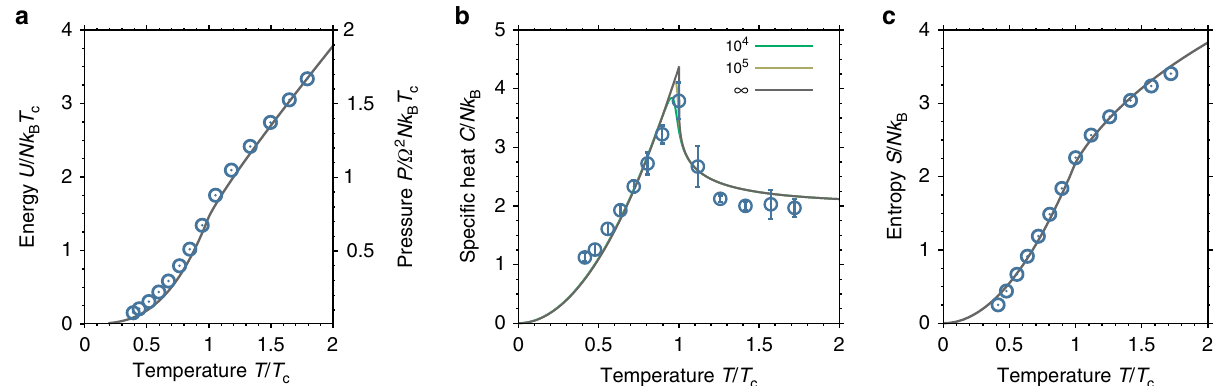
Figure 3 | Caloric and entropic properties. ( a ) Internal energy (per photon) U normalized to the characteristic energy k B T c as a function of the reduced temperature T / T c . In the classical high-temperature regime, energy scales linearly with temperature as is expected from Maxwell–Boltzmann-like statistics. The formation of the condensate is signalled by a change in slope close to T ¼ T c . For an ideal two-dimensional trapped Bose gas, which is realized in our experiment in good approximation, the internal energy of the photon gas can moreover be linked to its pressure P by P ¼ (1/2) O 2 U , see axis on the right- hand side and the main text for details ( O is the trapping frequency). Experiments are carried out at constant temperature T ¼ 300K and photon numbers ranging from N E 30,000 to N E 550,000, whereby an increase of the photon number corresponds to a decrease in the critical temperature T c ¼ T c ( N ) of the system. s.e.m.’s are smaller than the point size. ( b ) Specific heat (per photon) versus the reduced temperature T / T c , showing a cusp singularity at criticality (circles). In the high-temperature (classical) regime, the specific heat reaches a limiting value of 2 k B per photon. At criticality T ¼ T c , the heat capacity reaches a maximum value of C ( T c )/ N ¼ (3.8 ± 0.3) k B . The solid lines give the specific heat of the two-dimensional harmonically trapped ideal Bose gas for varying total particle numbers. The error bars indicate s.e.m. ( c ) Entropy per photon as a function of the reduced temperature T / T c (circles), along with the theoretically expected ideal Bose gas behaviour (solid line). The data are derived from a numerical integration of the specific heat curve of b (see text for details). The entropy monotonically decreases for decreasing temperatures, reaching a minimum value of E 0.2 k B per photon at the lowest achieved temperature. s.e.m.’s are smaller than the point